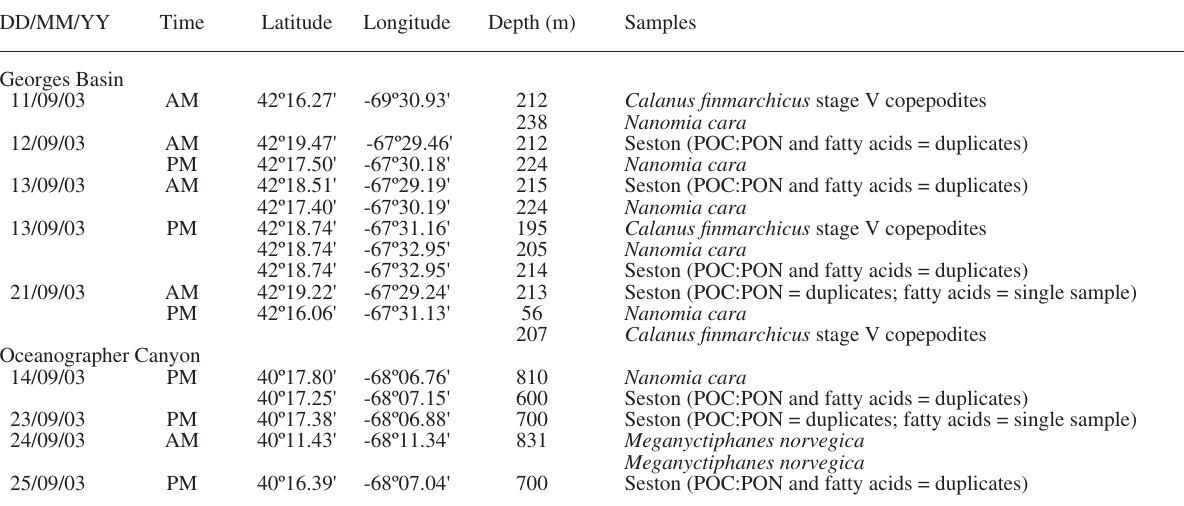
Table 1. – Details for collection of samples. aM, daytime; PM, nighttime; PoC:Pon, ratio of particulate organic carbon to particulate organic nitrogen.